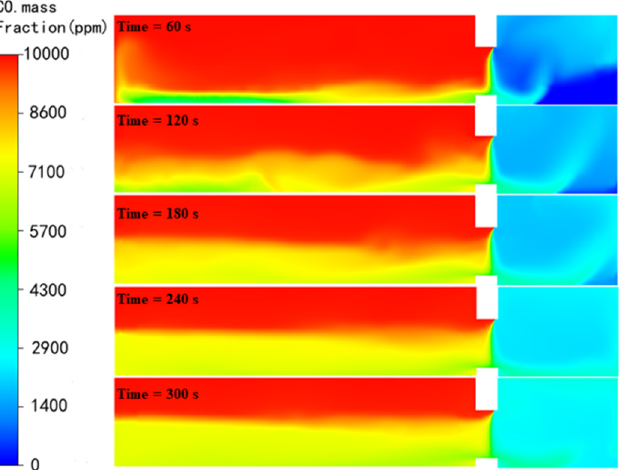
Figure 19. The CO concentration cloud diagram of the transition room when the jet angle is 10° at Y = 1.805 m.